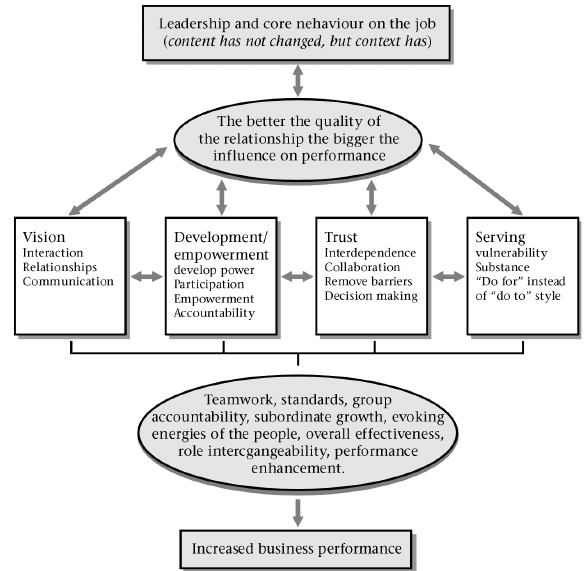
Figure 1 : Leadership/employee relationship